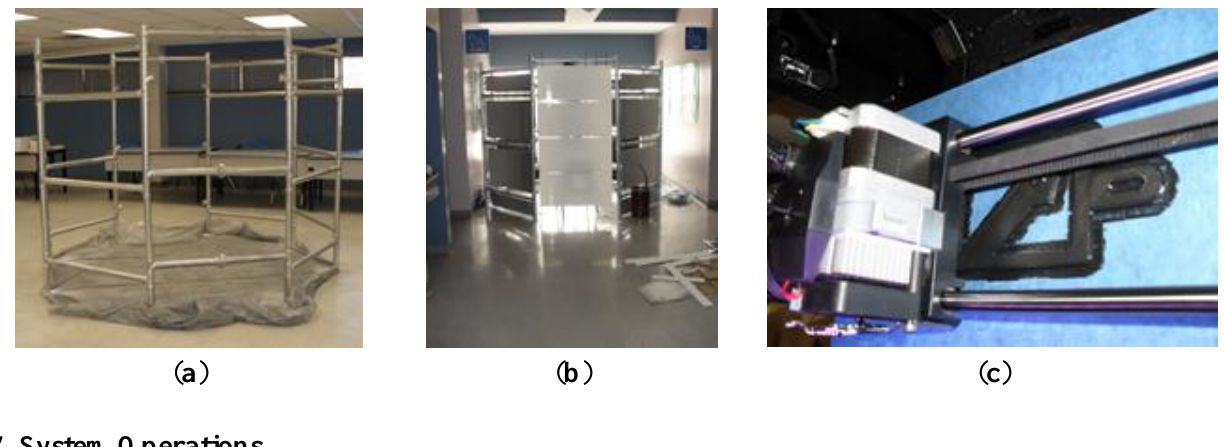
Figure 8. ( a ) Frame painting completed; ( b ) Frame with panels added; ( c ) MakerBot 3D Printer creating Raspberry Pi mount.